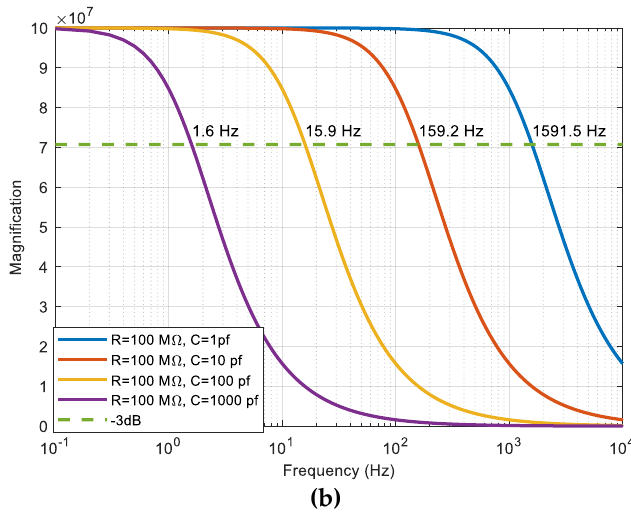
Figure 18. ( a ) Schematic of the measurement circuit, and ( b ) amplitude response of the circuit under different parameter settings.